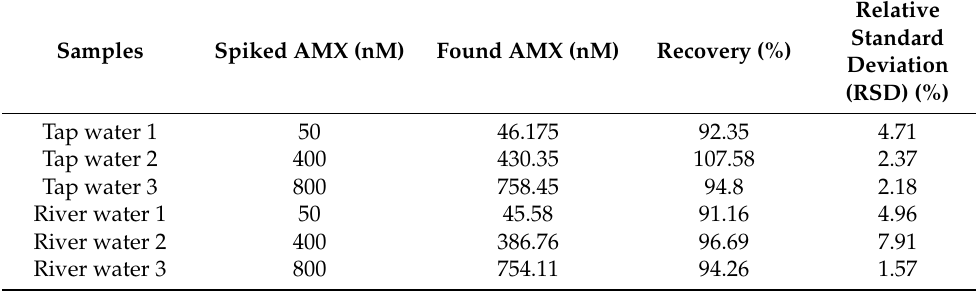
Table 2. Determination of AMX in spiked real water samples ( n =